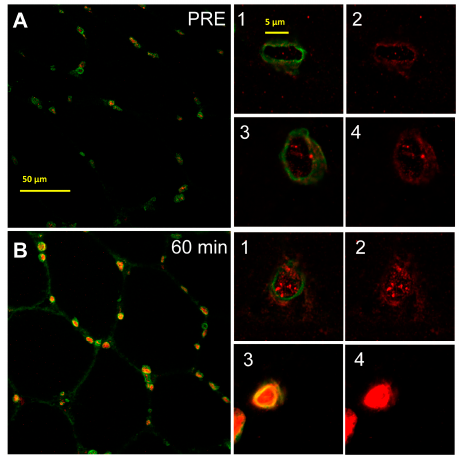
Figure 5. Cont. Figure 5.